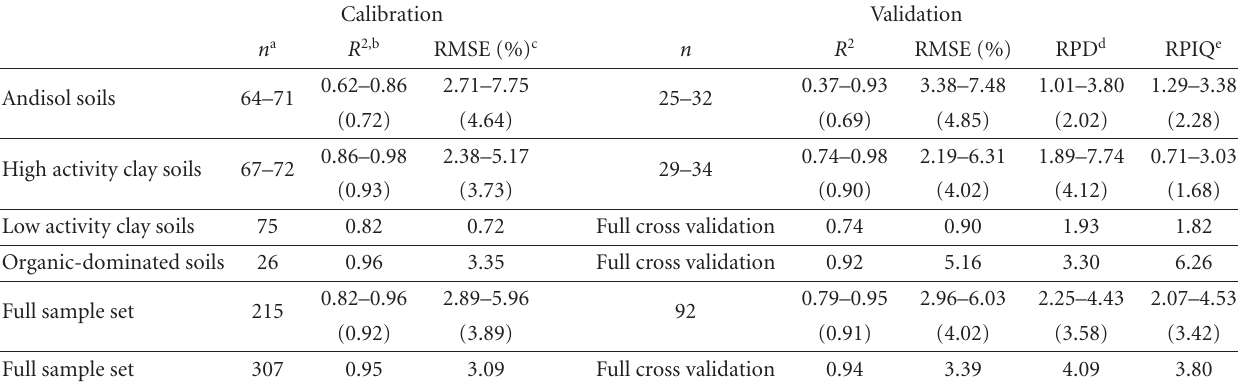
Table 4: Detailed partial least squares regression model results for soil total carbon (C t ) prediction from the subsets of visible/near-infrared di ff use reflectance spectra based on soil order. The range of values reflects the results of 10 random iterations of the models, and the number in parentheses is the mean. Detailed results are also given for full sample set models with no subsetting for comparison. For models with full cross validation (i.e., leave-one-out cross validation), the same samples used to calibrate the model were used to validate the model.